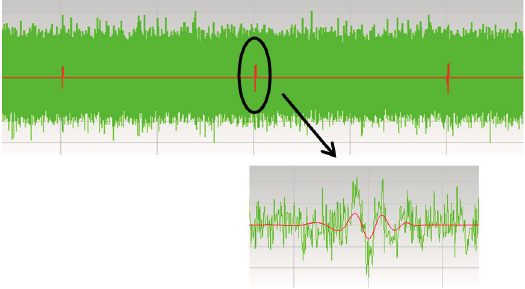
Figure 12. Result of the filtering tool. Discrimination of pulse-shaped signals overlaid with background